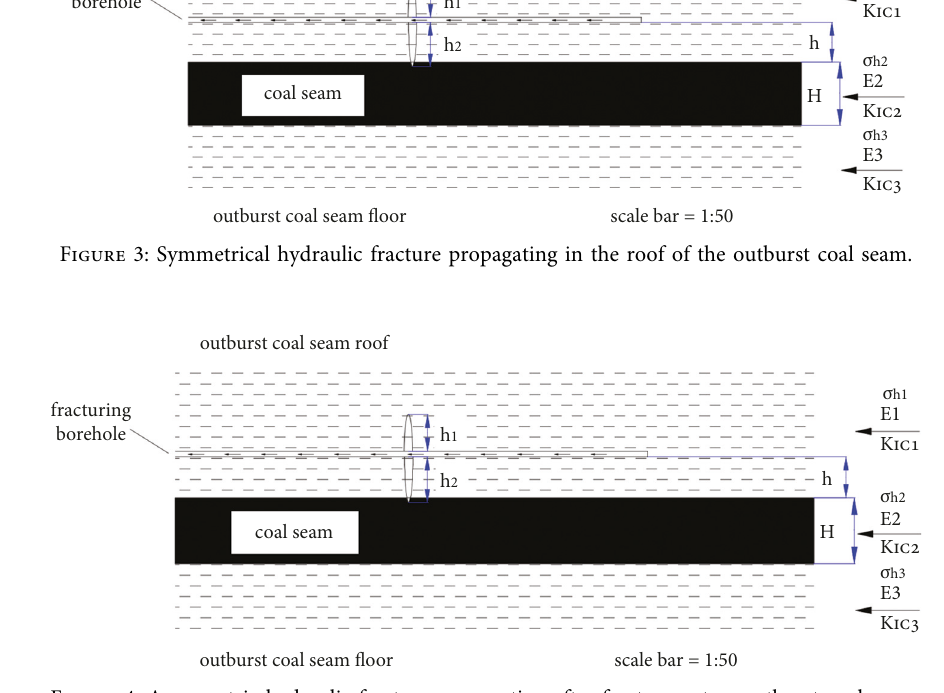
Figure 4: Asymmetric hydraulic fracture propagating after fracture enters outburst coal